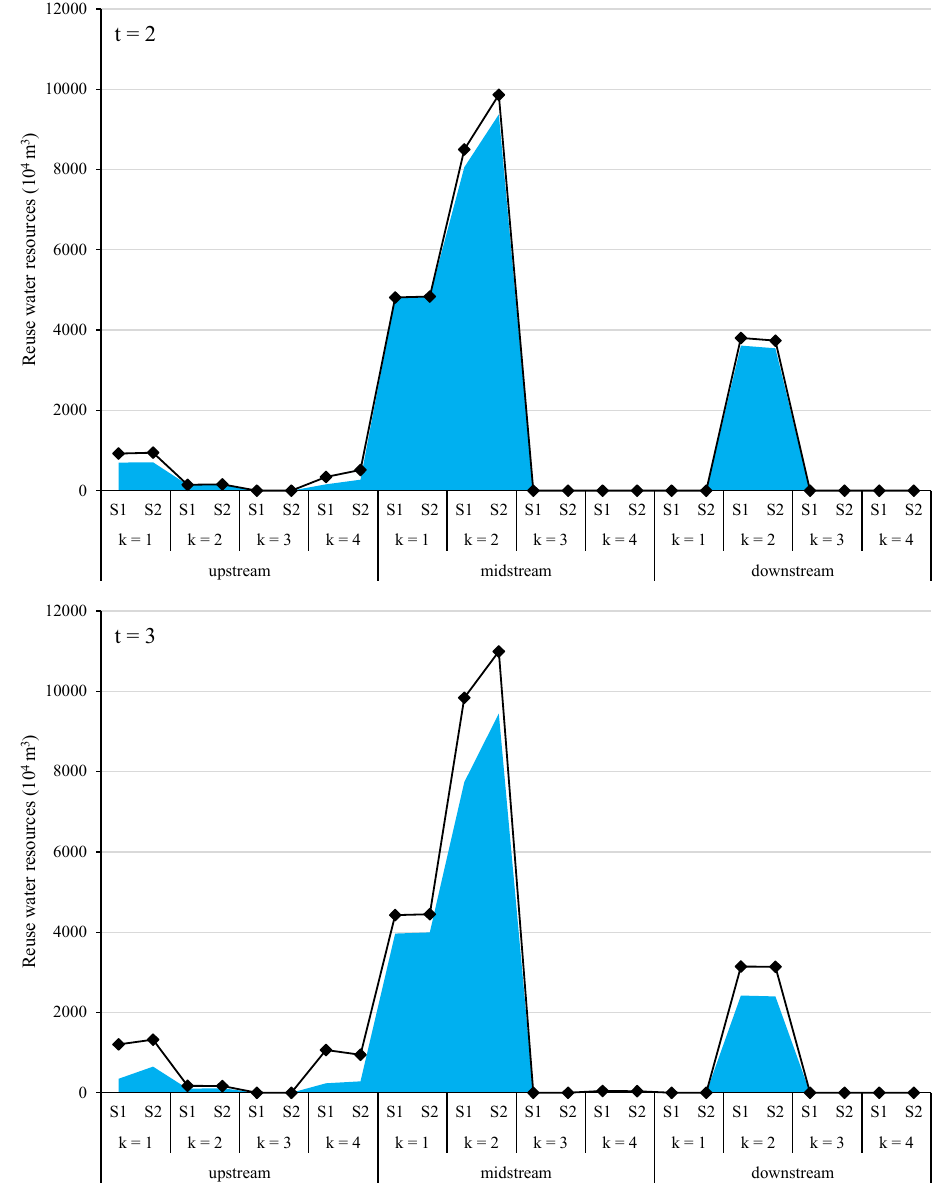
Figure 15. Reuse water resources in the Fenhe River Basin by scenario.